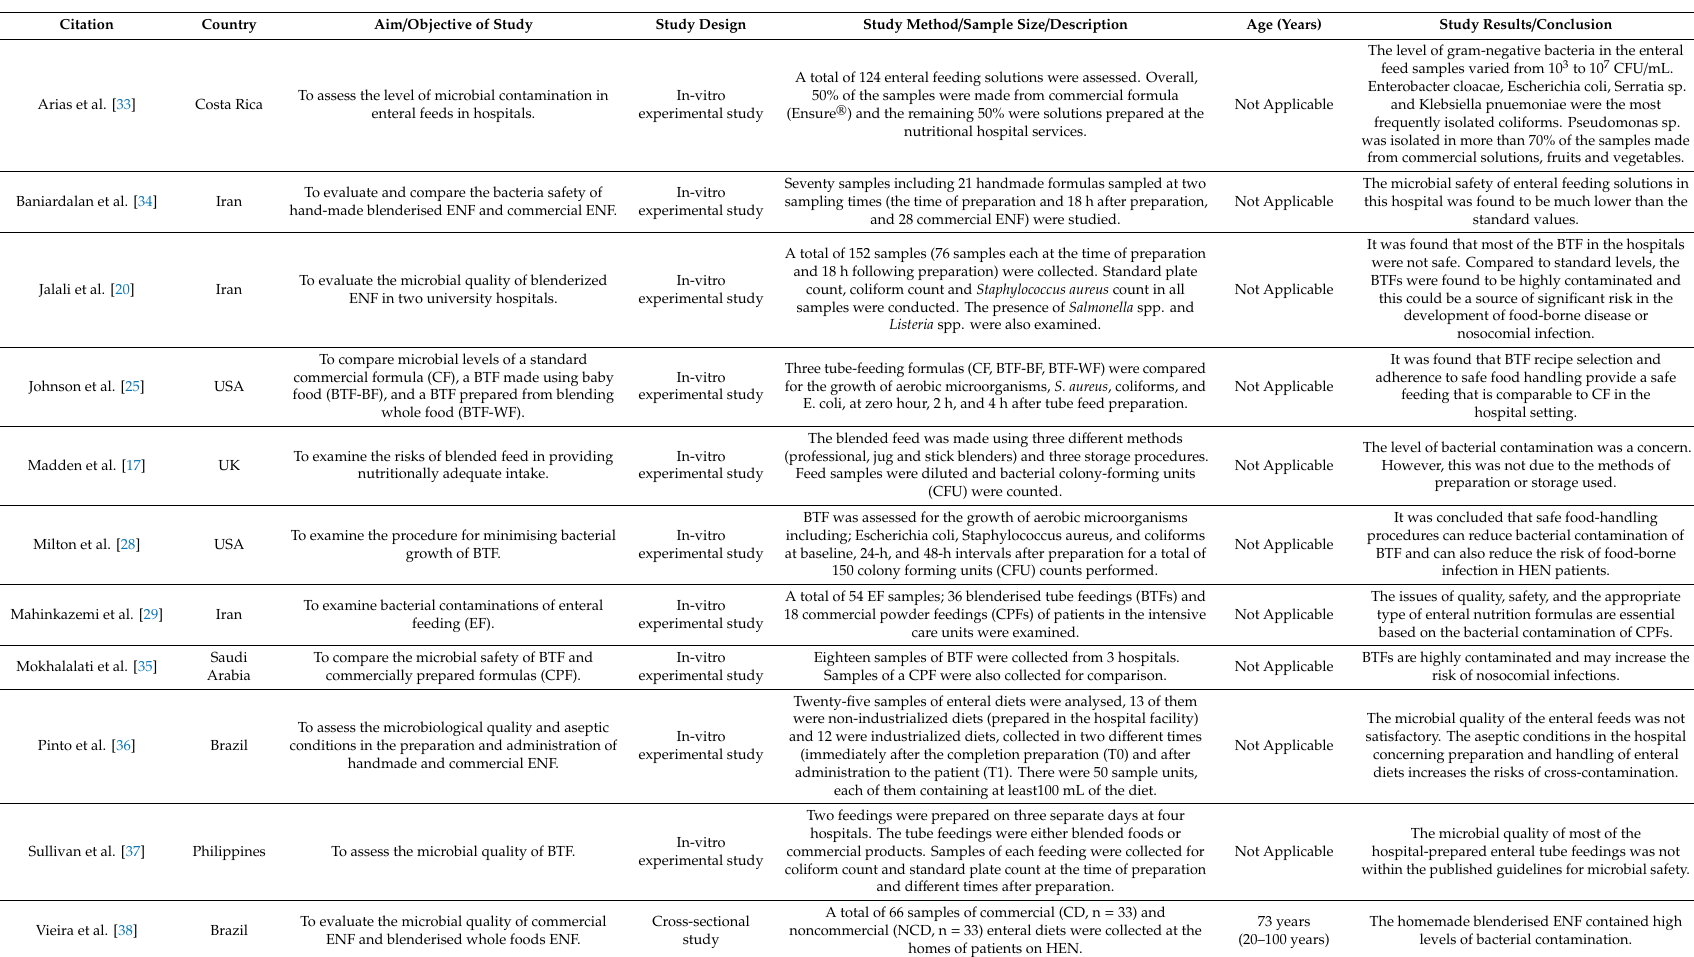
Table 2. Shows results of the data extracted from the studies